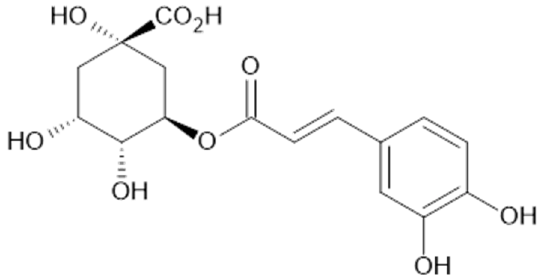
Figure 18. Chemical structure of compound 74 (MW = 354).